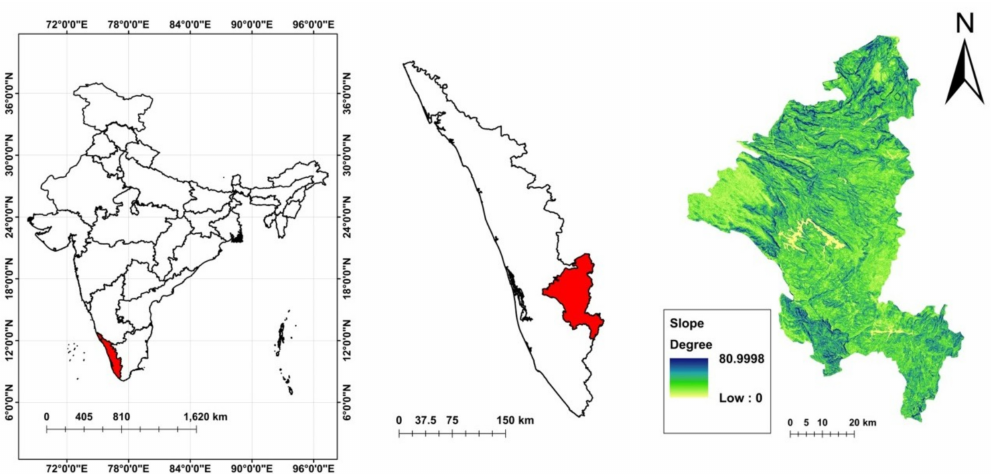
Figure 1. Location and slope map of the Idukki